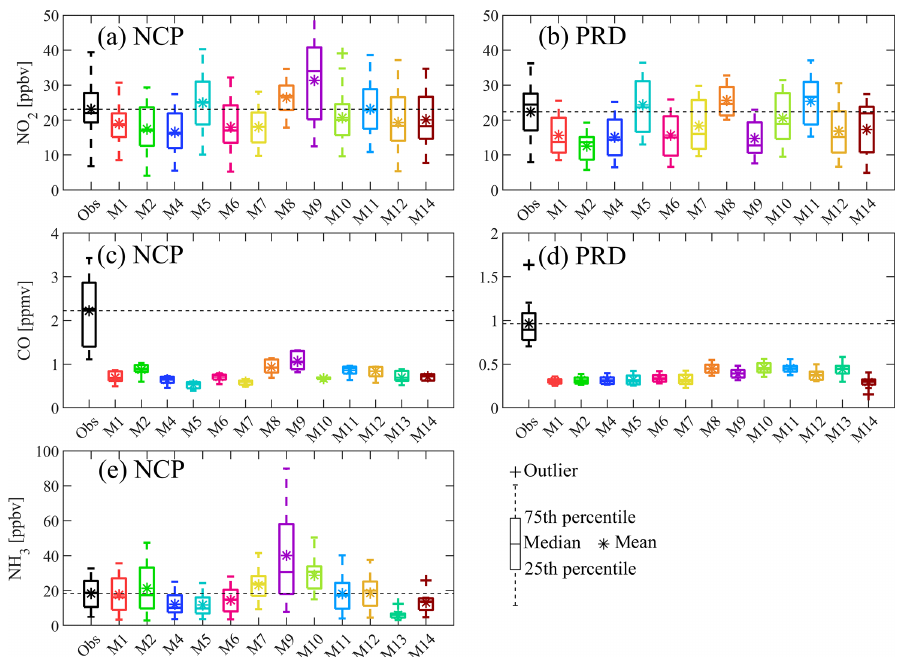
Figure 2. Boxplot of simulated and observed annual mean NO 2 , CO and NH 3 concentrations sampled from different stations over the NCP (a, c, e) and PRD (b, d) regions. The outlier was defined as values larger than q 3 + 15 × (q 3 − q 1 ) or less than q 1 − 15 × (q 3 − q 1 ) , where q 3 denotes the 75th percentile and q 1 the 25th percentile. This approximately corresponds to 99.3% coverage if the data are normally distributed.